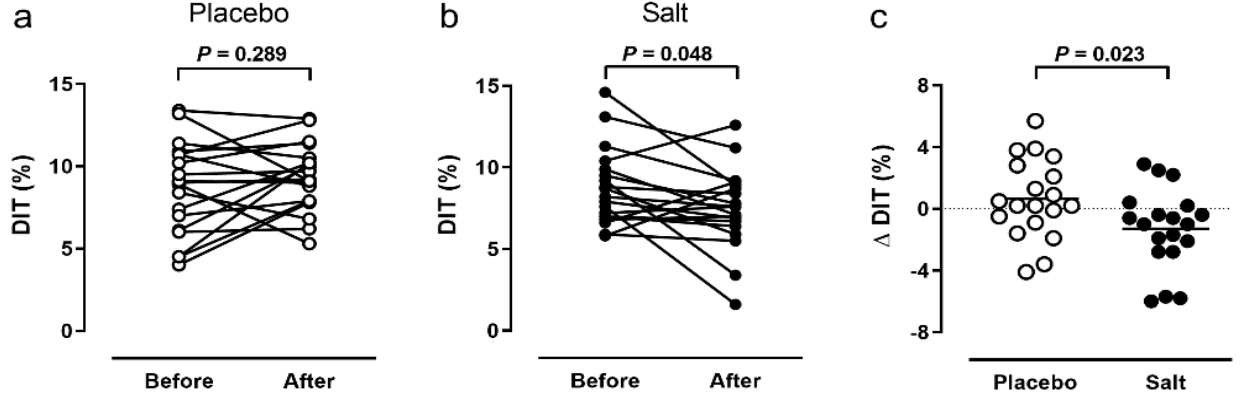
Figure 2. Primary outcome. Diet-induced thermogenesis (DIT) within 4 h after a 441 kcal breakfast before and after 2 weeks of placebo ( n = 19, ( a ) or salt ( n = 19, ( b ). Comparison of DIT changes between groups ( n = 38, ( c )). P value by Wilcoxon signed rank test ( a , b ) or Mann–Whitney U test ( c ).